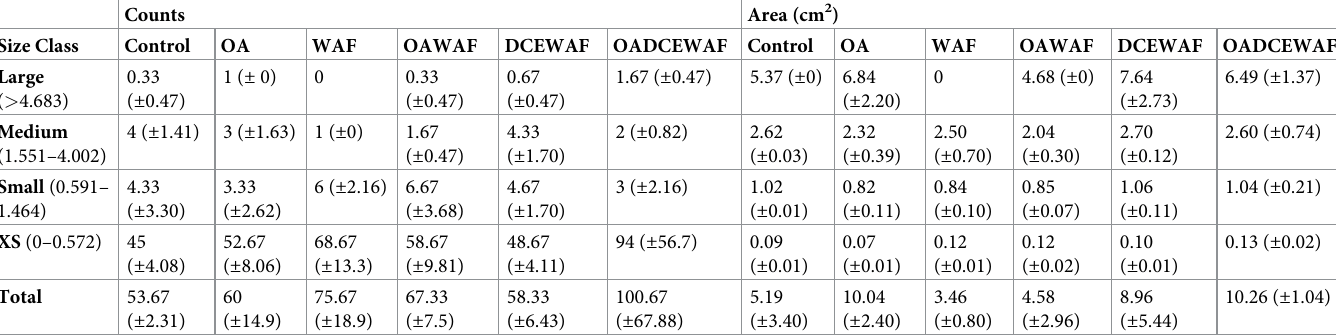
Table 2. Aggregate counts and area (cm 2 ) by size class in the roller table experiments. Error bars in brackets are standard deviation of triplicates.